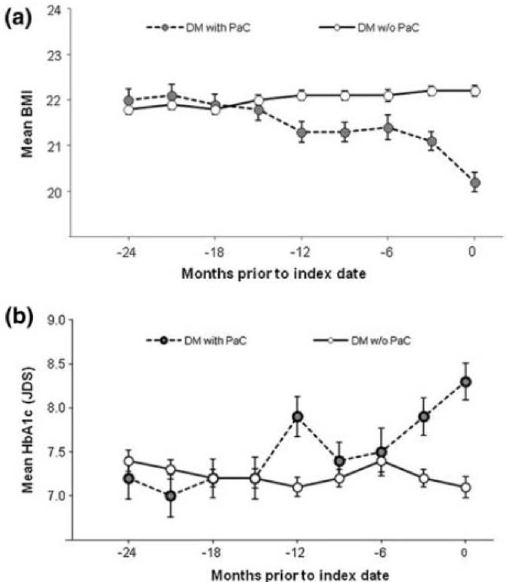
Figure 4. Temporal changes in ( a ) body mass index (BMI) and ( b ) hemoglobin A1c (HbA1c) in diabetic patients with pancreatic cancer (black circle with dashed line) and those without (white circle with solid line). This figure is adopted from Mizuno S et al. [43]. Bars indicate standard error of the mean. DM, diabetes mellitus; PCa, pancreatic cancer.